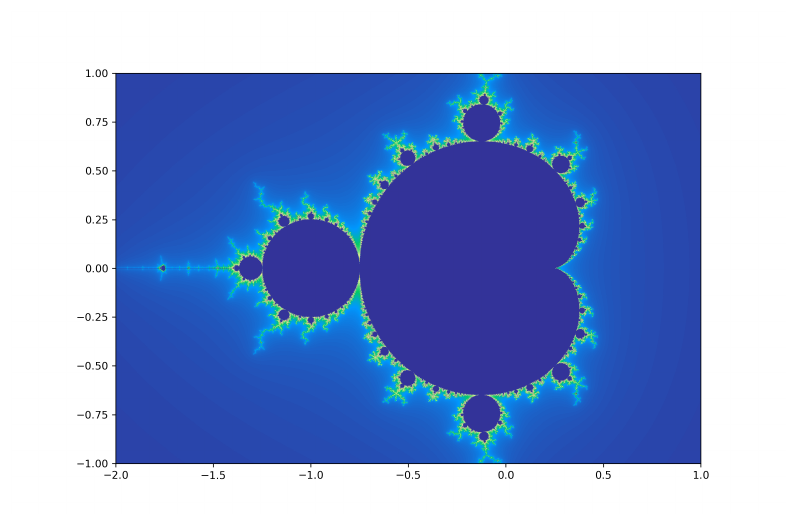
Figure 1. Mandelbrot set colored using continuous coloring. Each complex coordinate c is determined as within the set if the expression z n + 1 = z 2 n + c does not diverge after a given set of iterations. The number of iterations performed for each thread is shown here using a continuous color scale. Locations close to the boundary perform many iterations, whilst only a few iterations are required far away. It is evident that threads in close proximity may perform a very different number of